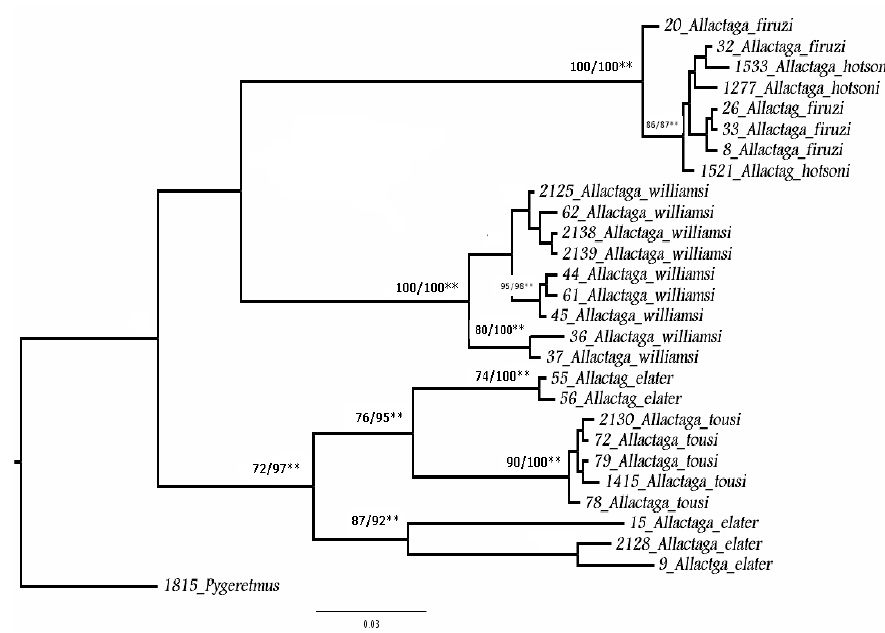
F IG . 2. Ninety-percent majority-rule consensus tree sampled from the posterior distribution of the most-partitioned analysis. Posterior probability values from the Bayesian analysis are indicated at the >99% (**) >95% (*) significance levels. Numbers represent ML and MP bootstrap values (500/5000 replicates; given only if >50%).